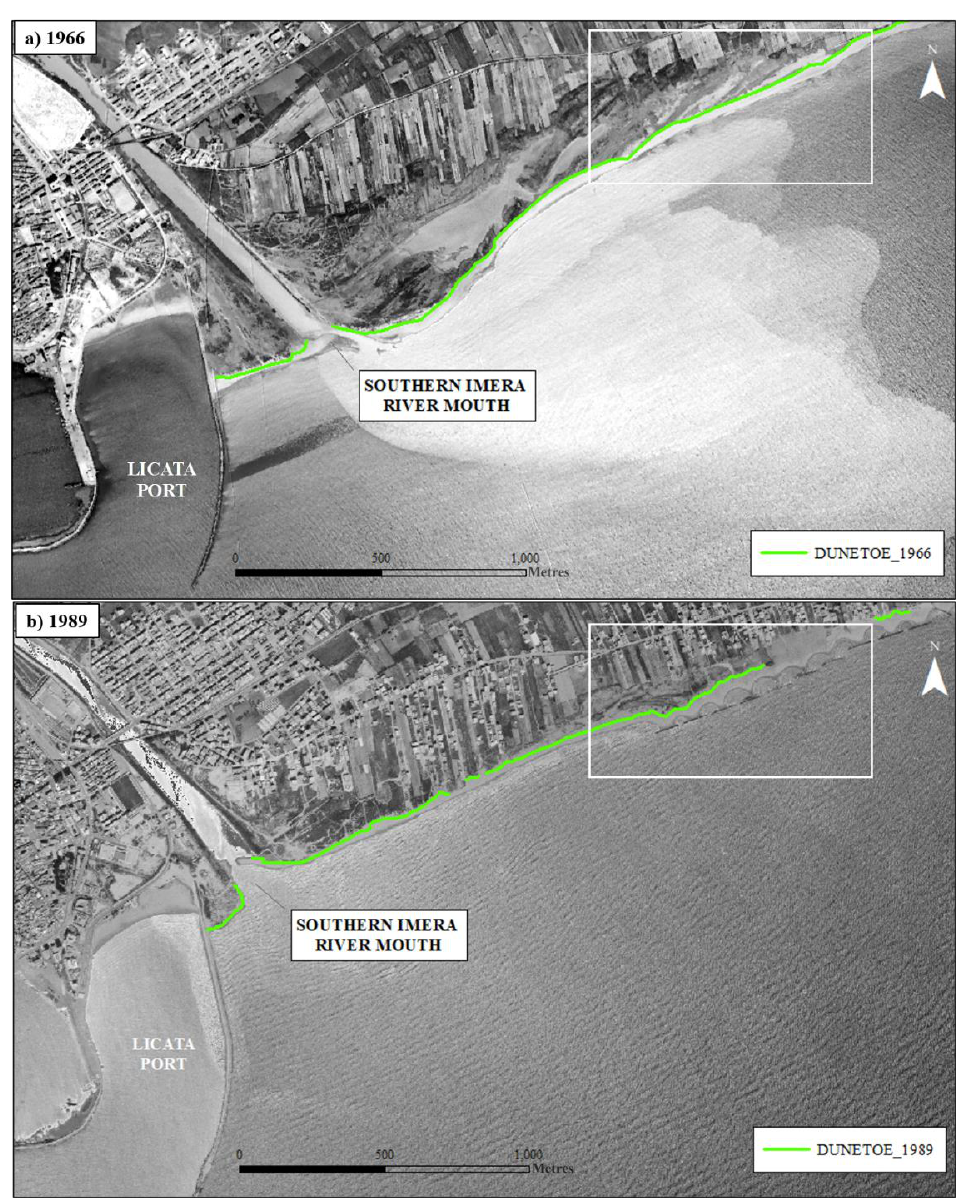
Figure 8. Dune toe detected nearby the Licata port on the 1966 aerial photo and on the 1989 orthophoto. ( a ) The dune system in 1966 is several kilometres long and only interrupted by physio- graphic or natural elements. ( b ) In 1989, the dune ridge significantly retreated (white square) and was partly interrupted by manmade works. Green line is the dune toe proxy.